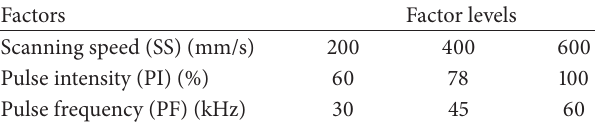
Table 3: Factors and factor